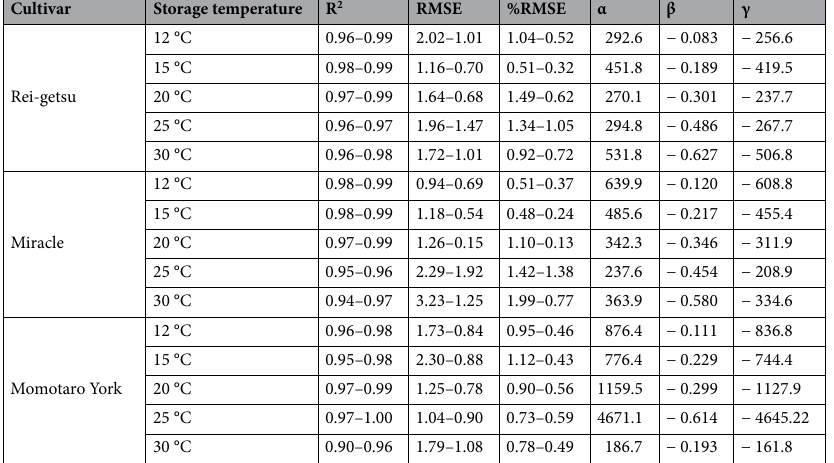
Table 1. Range value of the coefficient of determination (R 2 ), root mean square error (RMSE), %RMSE